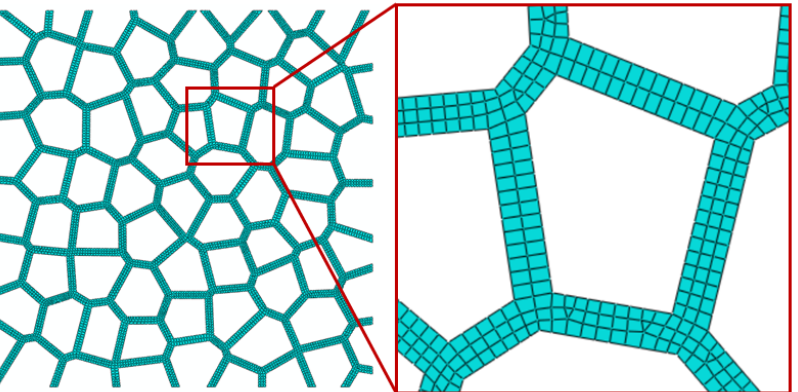
gated using a research methodology identical to the impact experiment. Specimens with porosities of 73.0% (0.729 g/cm 3 ) and 85.7% (0.386 g/cm 3 ) were subjected to the constant initial kinetic energies of 0.6 J and 0.15 J, respectively. The initial impact energy for differ- ent foam specimens was also determined through multiple impact simulations to satisfy the energy absorption requirements according to Equations (4) and (5). The variation in initial kinetic energy between experiments and simulations was attributed to the size and two-dimensional nature of the specimens during the impact simulation. Uniaxial impact simulations of different velocities of 10 m/s, 20 m/s, and 30 m/s were carried out with the FE code Abaqus/Explicit. The analysis step times of the models with impact velocities of 10 m/s, 20 m/s, and 30 m/s were 0.0010 s, 0.0007 s, and 0.0004 s, respectively, to ensure sufficient time for the complete impact simulation process. The specific parameter settings for the impact simulation were listed in Table 1. The load–displacement curves of the top rigid line (hammer) will be used in the analysis of the simulation results for the 2D Voro- noi-based foam specimens. In addition, this simulation study was particularly aimed at the deformation process of the specimens at higher impact velocities. Table 1. Parameters settings for the impact simulation. Porosity of Specimen